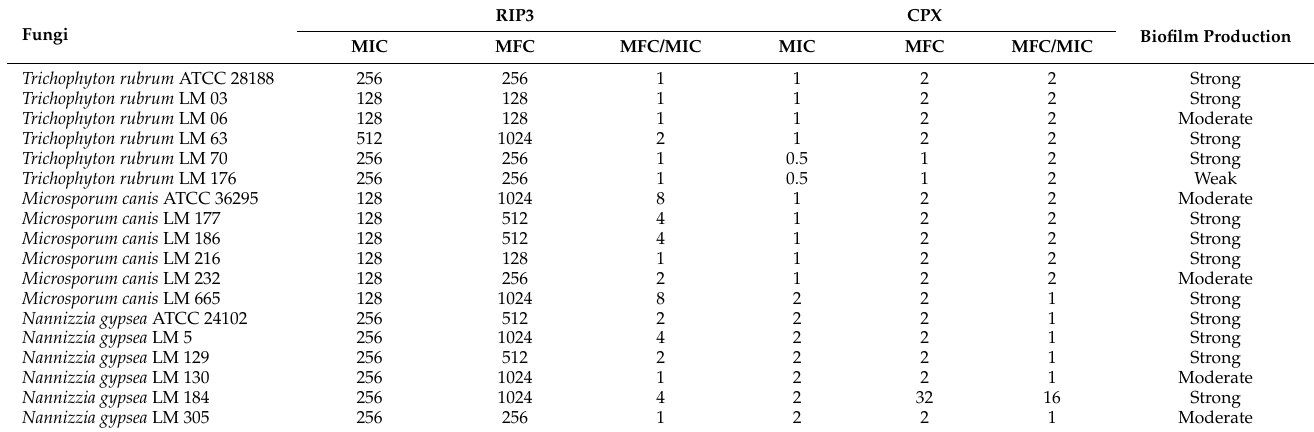
Table 1. MIC and MFC values (mg/L) of RIP3 and CPX against dermatophytes